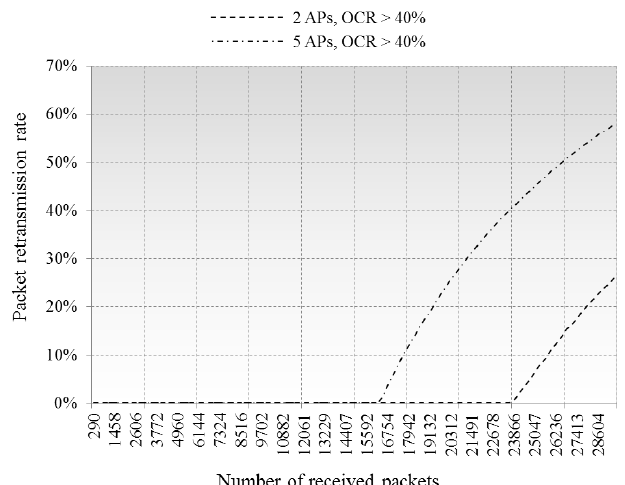
Figure 9. Comparison of racket retransmission rate.